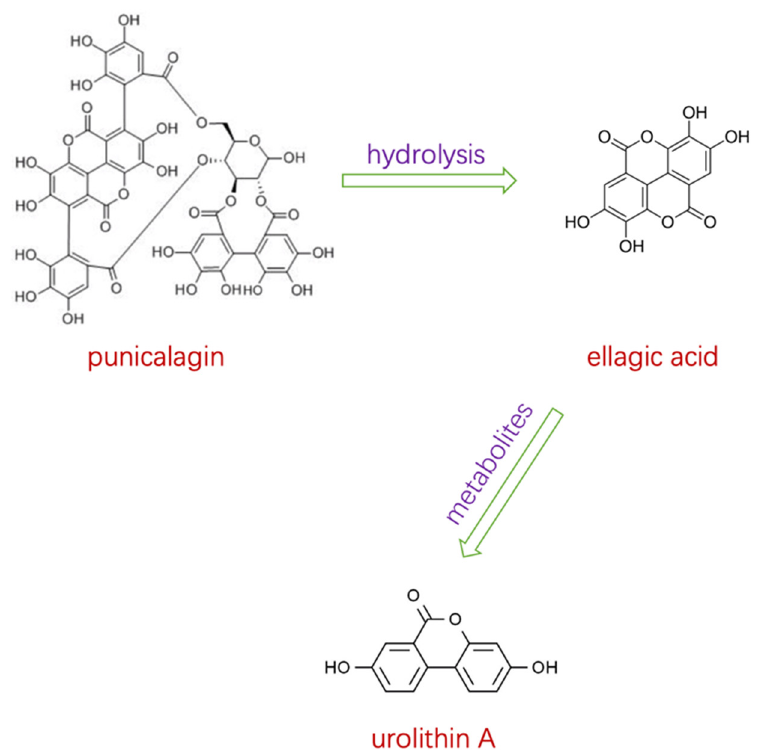
Figure 1. Punicalagin is hydrolyzed into ellagic acid in the small intestine, and is then metabolized to urolithin A.